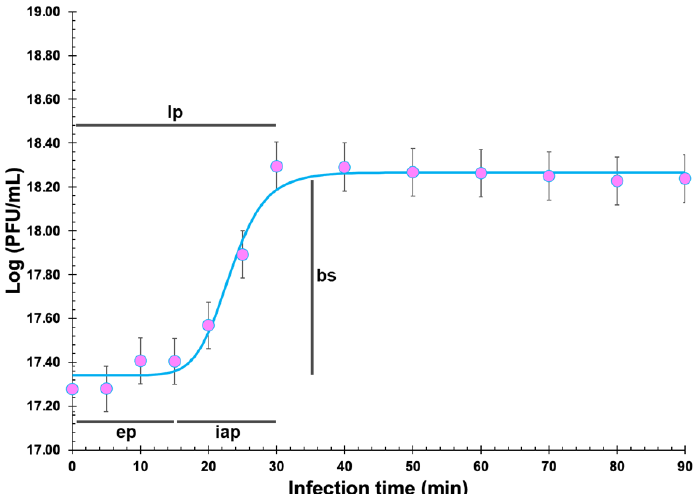
Figure 6. One-step growth curve of phage Kpn31 using K. pneumoniae CCCD-K001 as the host. The assay was performed with K. pneumoniae CCCD-K001 in the late exponential phase (10 8 CFU/mL) and phage Kpn31 at a titre of 10 5 PFU/mL (MOI ≤ 0.001). The phage growth data were adjusted via nonlinear fitting to a typical sigmoidal (or four-parameter logistic regression) model to estimate the phage eclipse (ep), latent (lp), and intracellular accumulation (iap) periods and burst size (bs) as indicated. Values are the means of three independent assays. Error bars represent the standard deviations. lp: 30 min; ep: 15 min; iap: 15 min; bs: 9.12 PFUs/host cell.